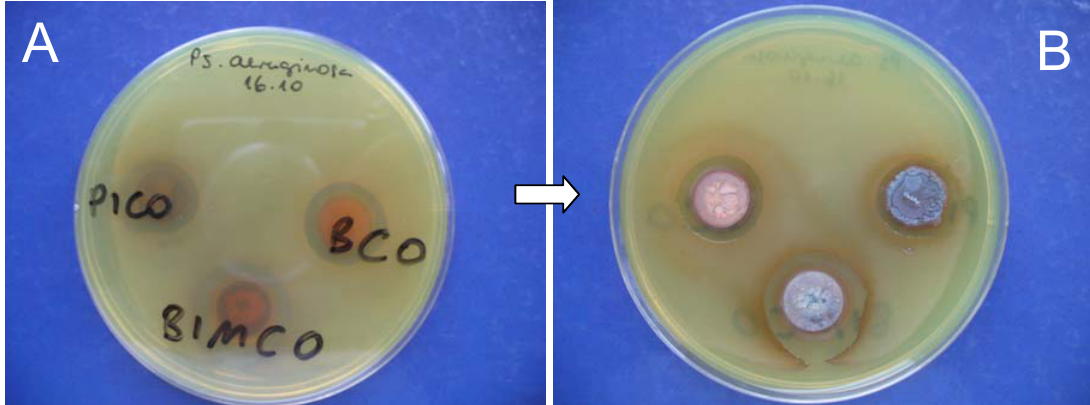
Figure 23. Zones of inhibition by Ag(PiCO), Ag(BCO) and Ag(BIMCO) pellets in P. aeruginosa growth on solid media. Photographs of the agar plate showing zones of inhibition: ( A) top view, ( B) bottom view.